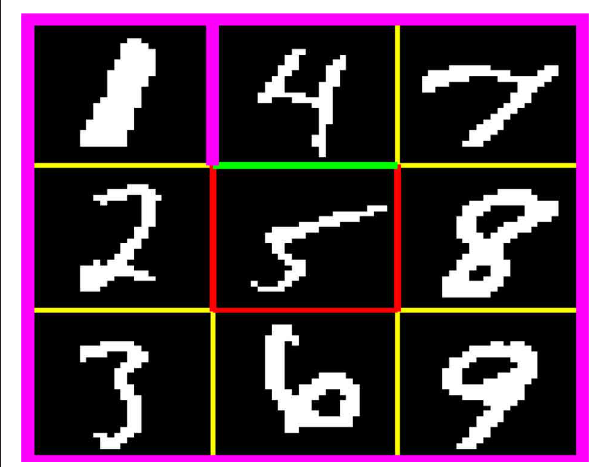
FIGURE 2 | Digit floor gridworld task. The thick purple lines indicate the outer walls and the wall between states “1” and “4.” The yellow lines indicate zero reward state transitions. The red lines indicate negative reward ( − 0 . 01) for premature state transitions to the absorbing goal state (state “5”) from states “2,” “6,” and “8.” The green line indicates positive reward ( + 1) for successful completion of the task, i.e., state transition from state “4” to